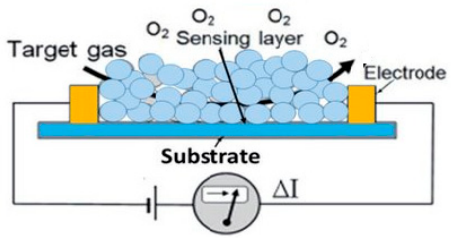
Figure 4. Gas sensing mechanism of metal oxides. Adapted from [75].